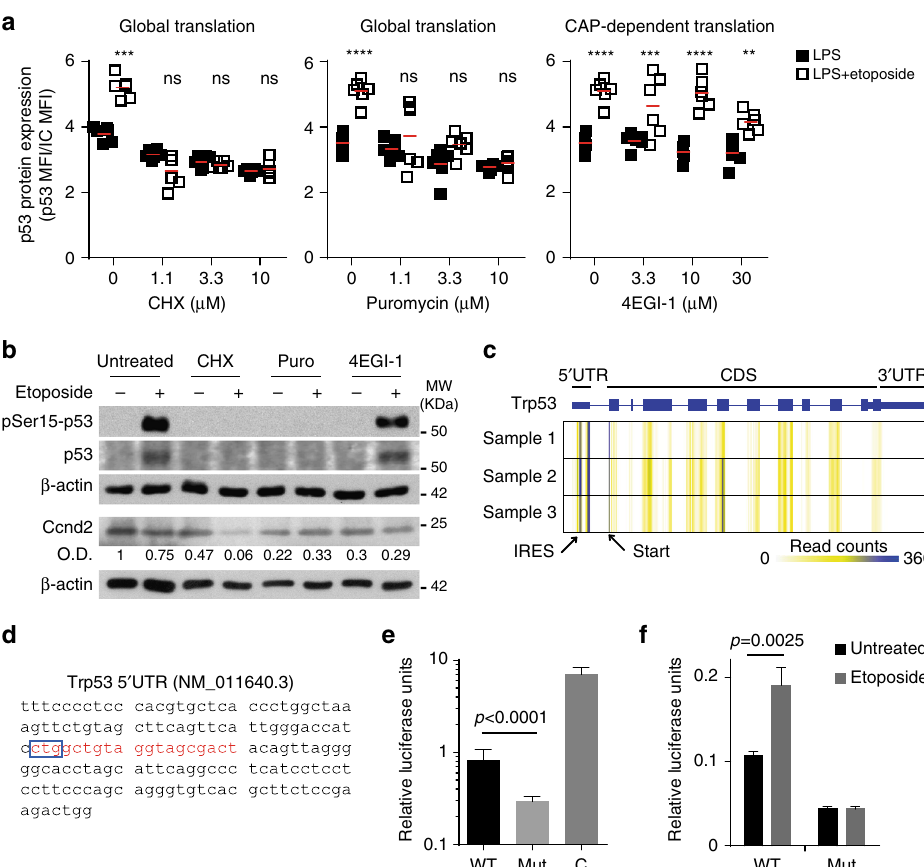
Fig. 8 CAP-independent translation controls p53 protein synthesis in B cells upon DNA damage. a Flow cytometry analysis of p53 expression after inhibition of global translation with cycloheximide (CHX, 10 μ M) or puromycin (Puro, 3 μ M), or after inhibition of CAP-dependent translation with 4EGI-1 (10 μ M). Data from six biological replicates collected in two independent experiments are shown. Two-way ANOVA and Bonferroni post-test analysis was performed ( ns non-signi fi cant, ** P < 0.01, *** P < 0.001, **** P < 0.0001). b Immunoblot analysis of pSer15-p53, p53, Ccnd2 and β -actin in B cells after inhibition of mRNA translation with CHX, puromycin or 4EGI-1. One of the two independent experiments performed is shown. Densitometry of Ccnd2 immunoblot after normalization by β -actin expression is shown relative to untreated cells. c Ribosome footprints mapped to p53 mRNA in LPS-activated B cells (GSE62148) 70 . Data from three biological replicates are shown as heatmaps. Blue lines mark ribosome footprint accumulation associated to the p53 ribosome entry site (reads in the fi rst exon) and the fi rst codon (reads spanning between the fi rst and the second exon). d Murine p53 5 ′ UTR nucleotide sequence cloned into the psiCheck2 plasmid to generate the bicistronic Trp53 IRES reporter construct. Sequence starting at the P-site (based on ribosome footprints; blue box ) was mutated for Trp53 IRES characterization and it is shown in red . e Analysis of mRNA translation of the wild type (WT) or the IRES- mutated (mut) bicistronic Trp53 IRES reporter constructs. HEK293 cells were transfected in parallel with a psiCheck2 empty vector to produce